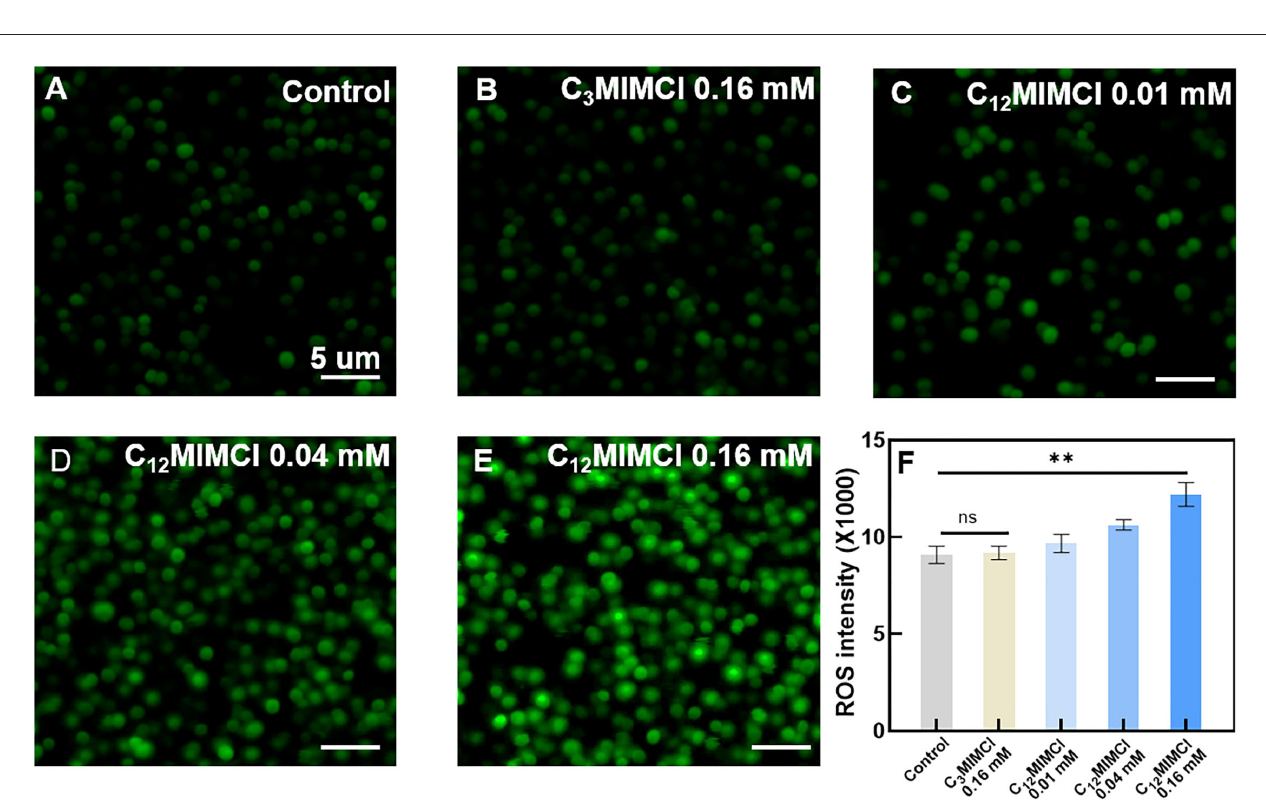
FIGURE3 Oxidative stress of Staphylococcus aureus. (A) CLSM images of ROS release from bacteria in control. (B–E) CLSM images of ROS release from bacteria in the presence of 0.16mM C 3 MIMCl (B) , 0.01mM C 12 MIMCl (C) , 0.04mM C 12 MIMCl (D) , 0.16mM C 12 MIMCl (E) . (F) Quantitative analysis of ROS release by a microplate reader. Data in (F) represent the mean ± s.d. Statistical significance of (F) was calculated via two-tailed unpaired Student’s t -test. Ns means no significant difference, ** P <